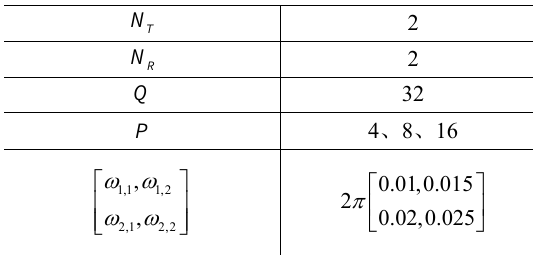
Table 2. Simulation parameters of quasi-optimal multi-